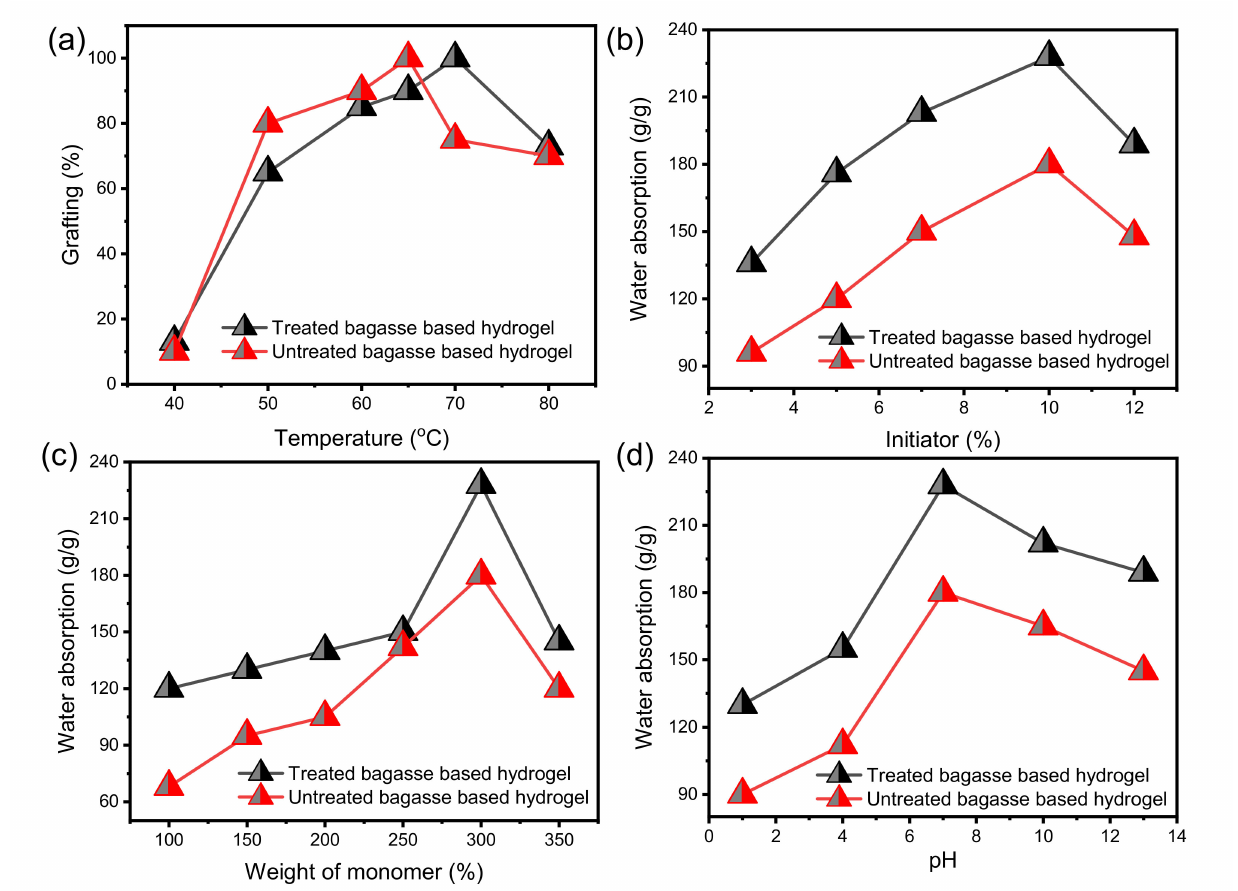
Figure 2. The influence of different reaction conditions on synthesis of hydrogel: ( a ) temperature, ( b ) concentration of initiator, ( c ) concentration of monomers, and ( d )